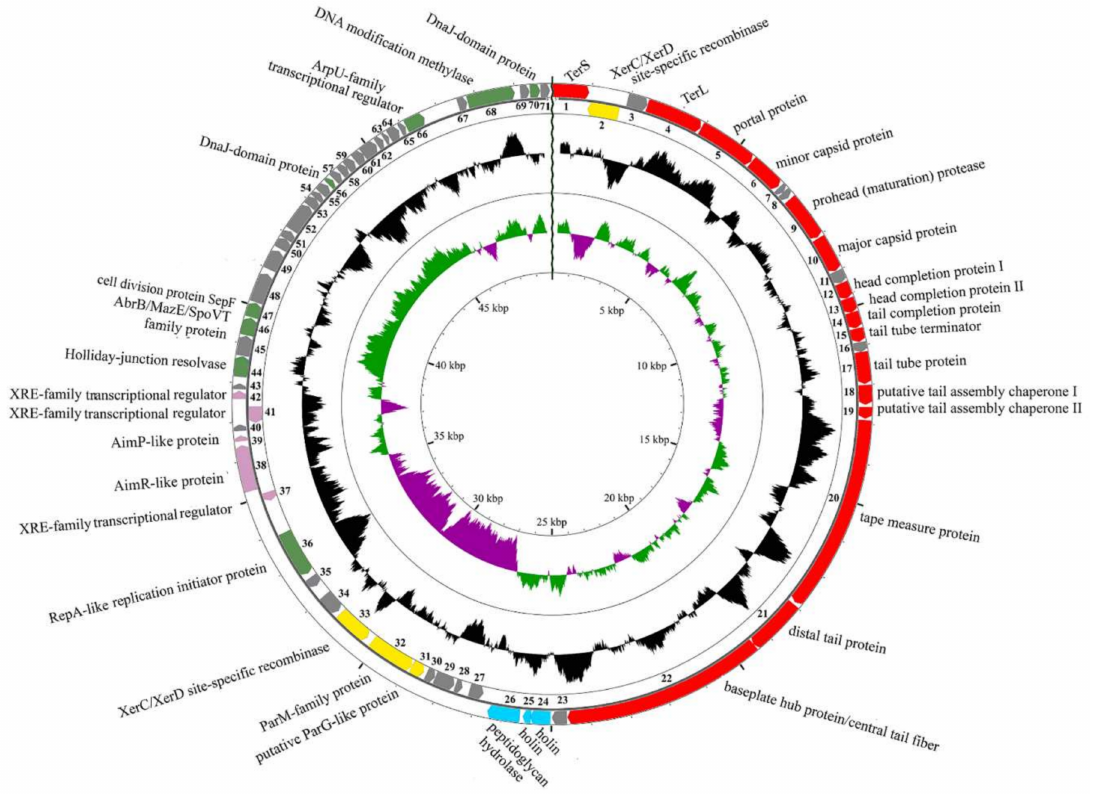
Figure 2. The B83 genome map. Red arrows – open reading frames (ORFs) with predicted morphogenesis functions, cyan arrows – lytic functions, yellow arrows – plasmid maintenance, pink arrows – lysis-lysogeny switch, green arrows – DNA replication, recombination and modification. Gray arrows indicate ORFs with unknown functions. Black middle diagram shows GC-content, and internal purple-green diagram shows